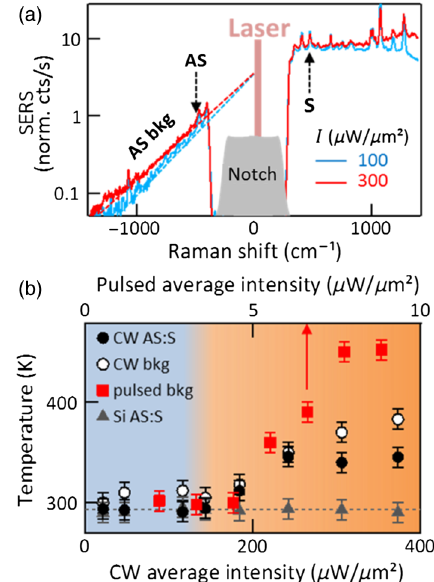
FIG. 15. (a) SERS intensities from a single NPoM at 100 μ W = μ m 2 (blue curve) and 300 μ W = μ m 2 (red curve) 633-nm CW excitation, normalized to a 475 -cm − 1 AS peak. Stokes and corresponding anti-Stokes peaks used in calculations are highlighted with arrows; anti-Stokes background fits are dashed lines. (b) Local temperature increase vs laser intensity for both CW (lower axis, circles) and pulsed (upper axis, squares) excitation. Temperature is extracted from the Stokes to anti- Stokes ratio (CW-black circles) or from the anti-Stokes back- ground (white circles for CW, red squares for pulsed). Reference temperatures from the bulk silicon are shown in grey. Shading shows linear (blue) and nonlinear (orange) Stokes regimes in the pulsed excitation case. [Fig. 15(b) blue region R ] shows a negligible temperature L increase for both CW (white circles) and pulsed (red squares) excitation. By contrast, in the nonlinear R NL regime [Fig. 15(b) orange region], a linear temperature increase is observed, reaching 380 K (CW) and 420 K (pulsed) for 300 μ W = μ m 2 excitation. A different “ molecular temperature ” within the plasmonic nanogap is